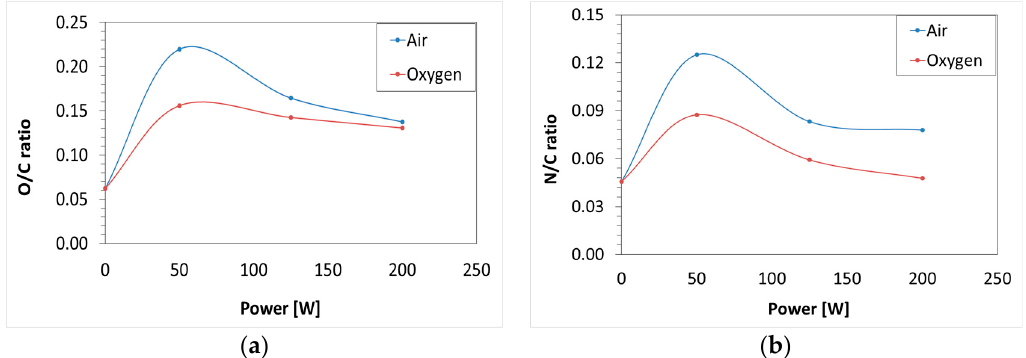
Figure 4. X-ray photoelectron spectroscopy (XPS) atomic ratios O/C ( a ) and N/C ( b ) of polypropylene surfaces with respect to plasma treatment parameters. surfaces with respect to plasma treatment parameters.